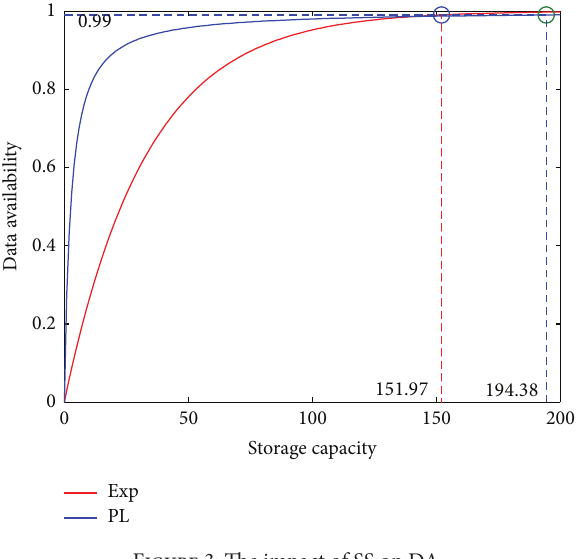
Figure 3: The impact of SS on